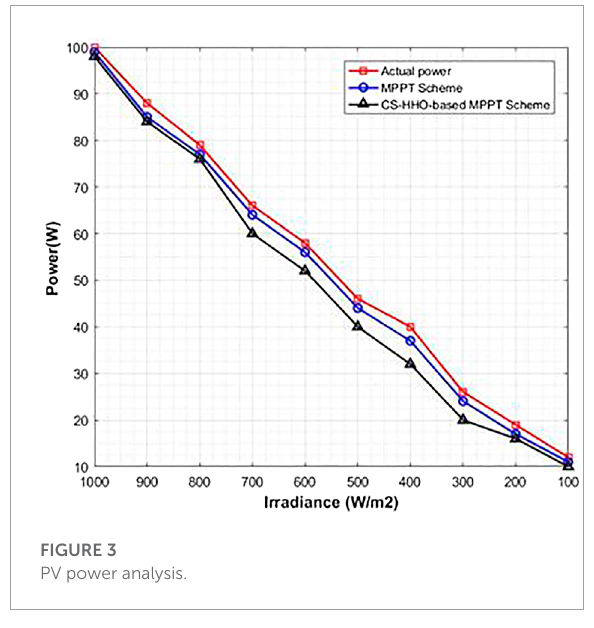
FIGURE 3 PV power